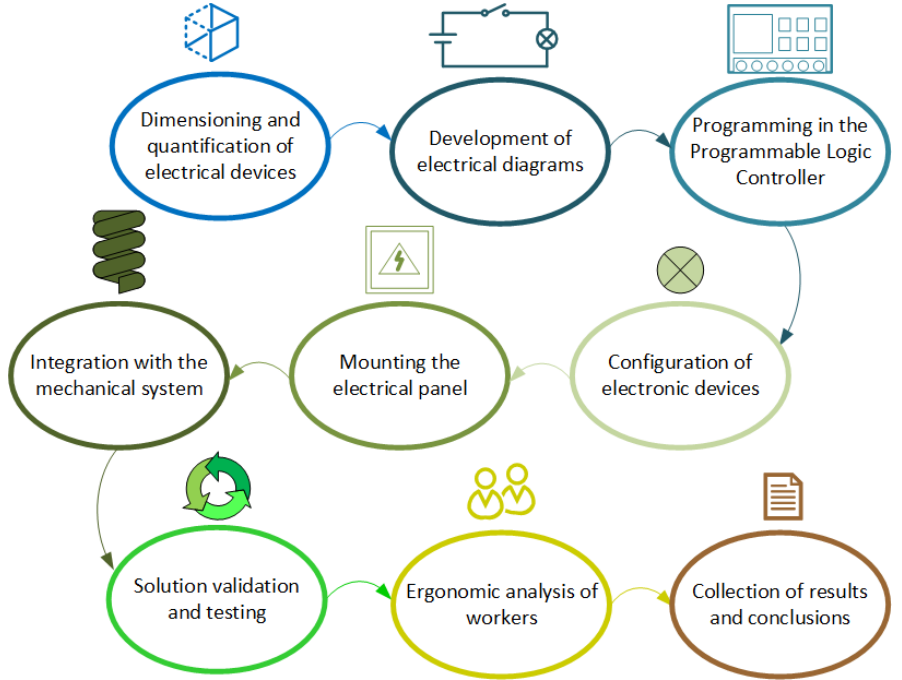
Figure 2. Methodology used for system development.